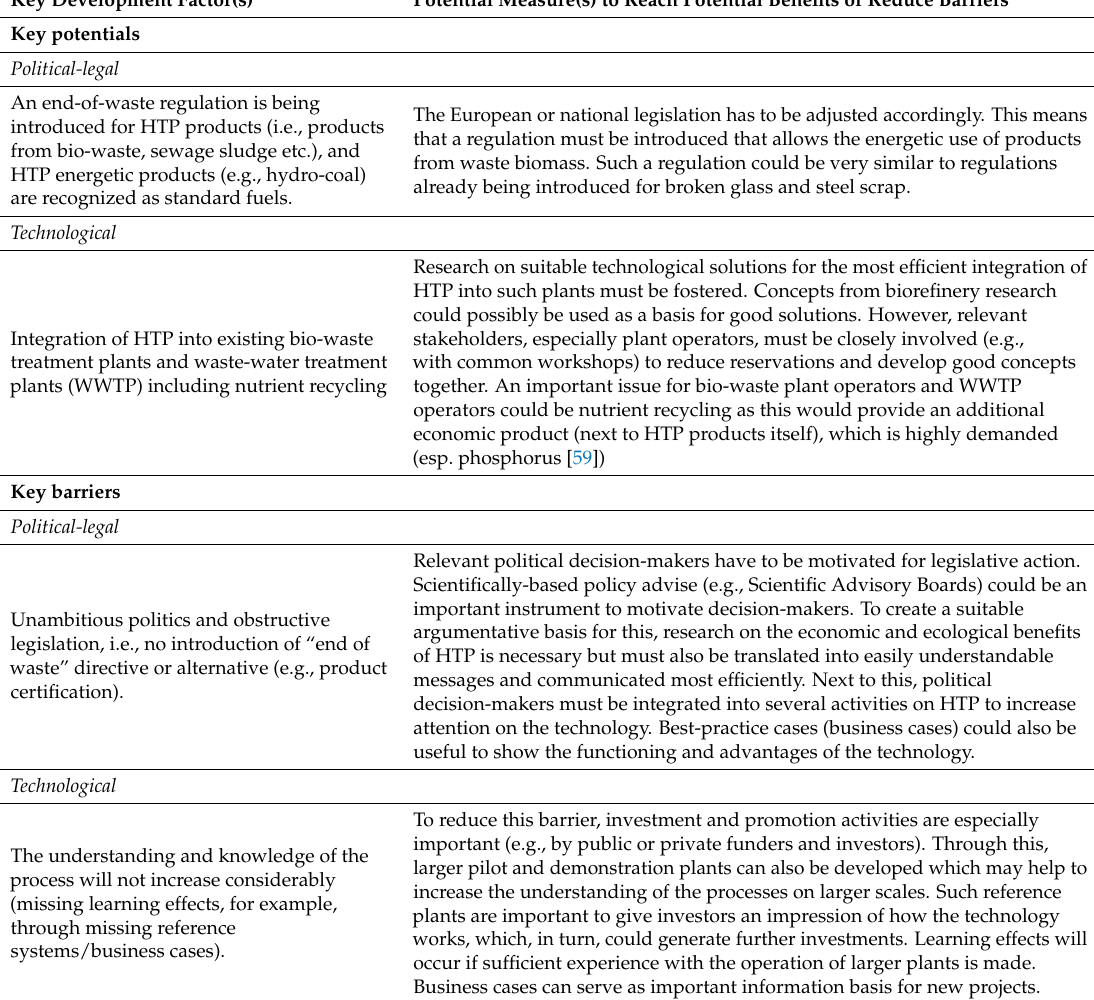
Table 4. Consensual key potential benefits and barriers for HTP development in Germany by 2030 and potential